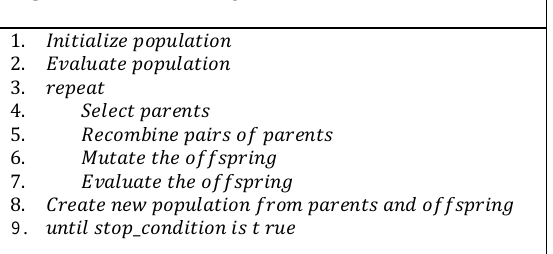
Figure 2. Pseudo-Code of